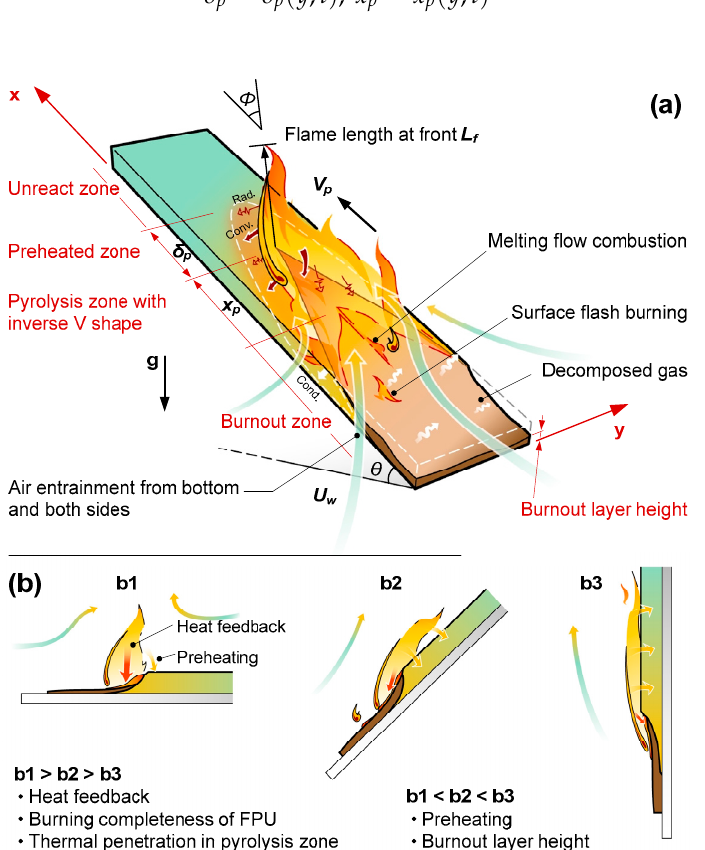
Figure1. Configurationofupwardflamespreadoverflexiblepolyurethane(FPU)foam( a ) and variation Figure 1. Configuration of upward flame spread over flexible polyurethane (FPU) foam ( a ) and of heat transfer intensities with increasing inclination ( b variation of heat transfer intensities with increasing inclination ( b ).